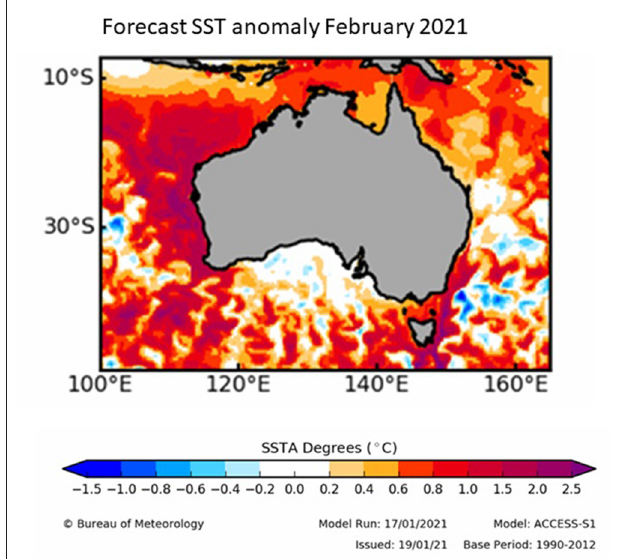
FIGURE 2 | Sea surface temperature anomalies predicted for February 2021 by the Bureau of Meteorology (BoM) Australia using ACCESS-S1 model issued 19/1/2021 (http://www.bom.gov.au/oceanography/oceantemp/sst-